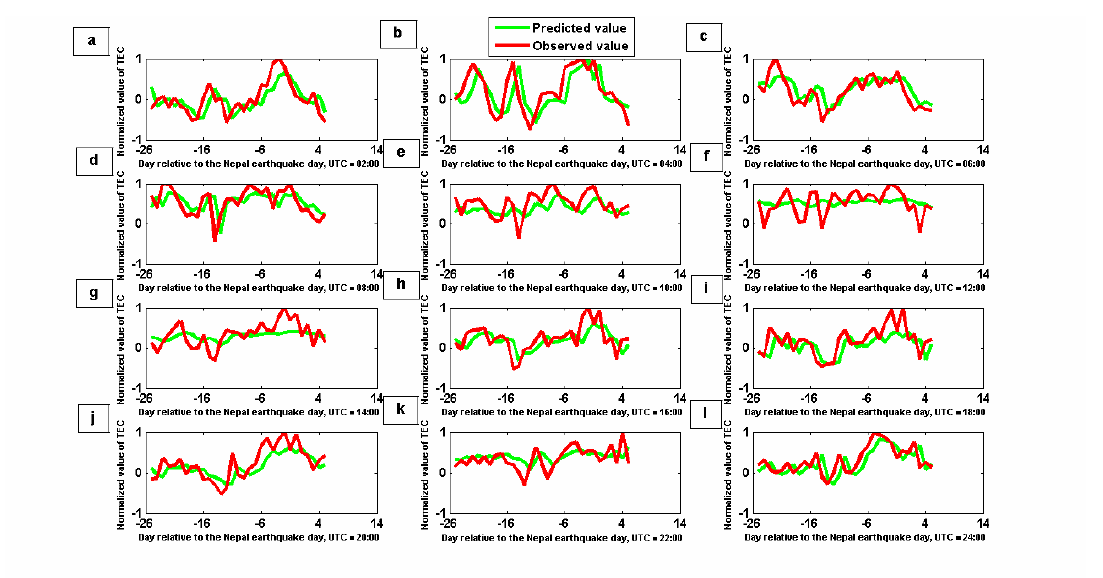
Fig. 3. a) through l) Variations of the observed (red curve) and predicted (green curve) TEC values obtained from ANN method during at different universal times. The X-axis represents the day relative to the Nepal earthquake